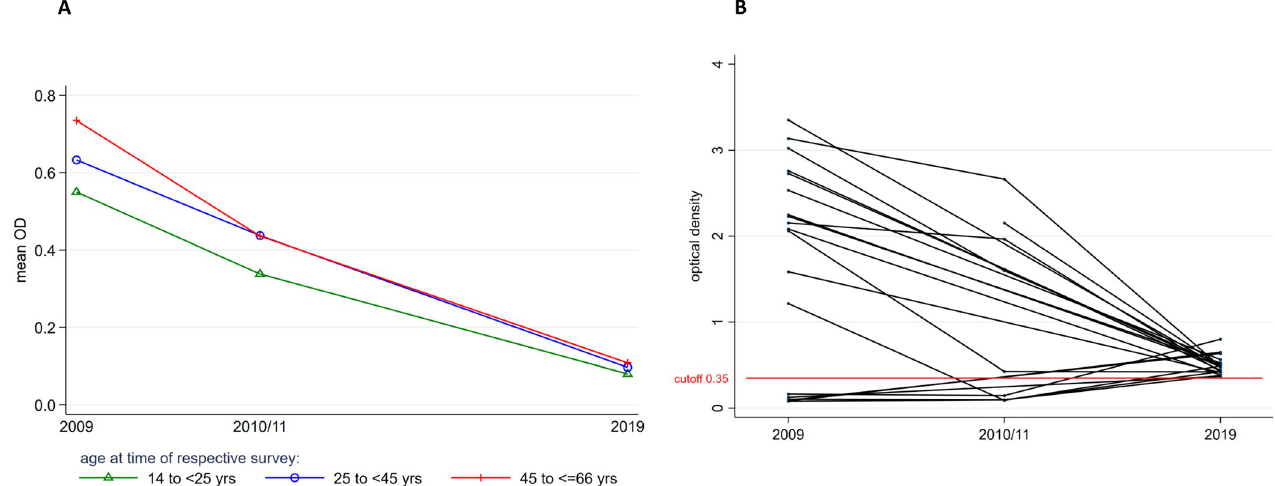
Fig 4. (A) Mean OD values over time categorized by age group.The OD values declined over time in all age groups. (B) OD values of Trop Bio ELISA from 2009, 2010/11 and 2019 from individuals who tested positive in 2019. Most of the remaining filarial infected individuals in 2019 had a positive result of the TropBio ELISA during the surveys in 2009 or 2010/11. Despite being still positive a significant drop of the OD was noted. Only four individuals had been tested negative before, but showed positive results in